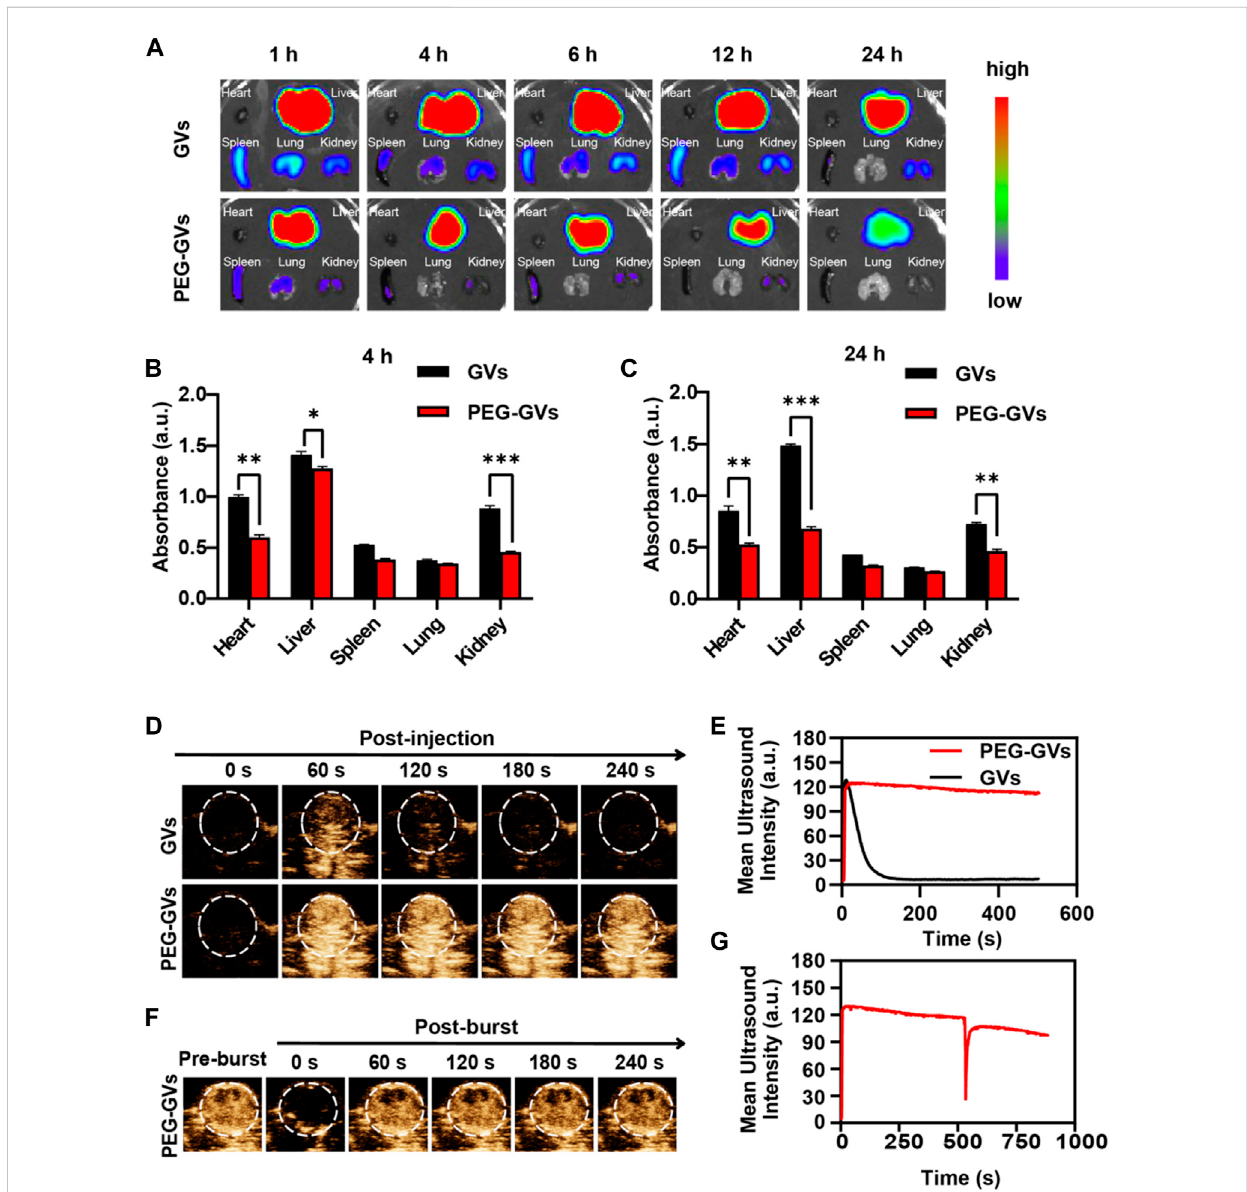
FIGURE 4 Invivo distributionofGVsandPEG-GVsandultrasoundimagingoftumors. (A) NIR fl uorescenceimagingof invivo organsinmicereceivedwithICG- labeled GVs or ICG-labeled PEG-GVs at different times. (B, C) Distributions of GVs and PEG-GVs in different tissues at 4 h (B) and 24 h (C) after tail vein injection. Error bars represent ± SD ( *p < 0.05, **p < 0.01, ***p < 0.001 ); (D) ultrasound contrast images of the tumors received with GVs or PEG-GVs. (E) Thecorresponding temporalaverageultrasoundsignal strengthcurves. (F) Ultrasound contrastimages oftumorreceivedwith PEG-GVsafter burst. The corresponding temporal average ultrasound signal strength curve shown in (G)